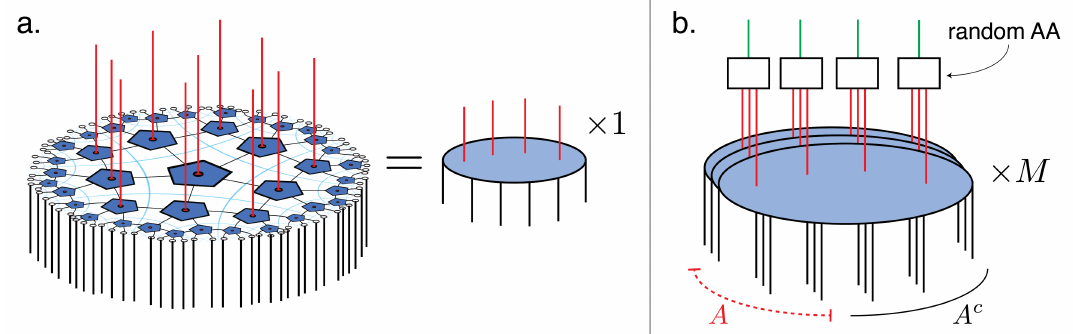
Figure 17 . Concatenating HaPPY codes to mimic the effect of finite G . We can view the HaPPY code as an encoding map (a) from a set of input boundary qubits (black) to a smaller set of output bulk qubits (red). To increase the ratio of boundary to bulk qubits, we consider stacking M HaPPY codes (b). We collect the M bulk legs at each point and scramble them into a single bulk qubit (green) using a random all-to-all (AA) scrambling circuit. Projective measurements on a region A (dotted red) are made separately on each layer of the stack in randomly-chosen local